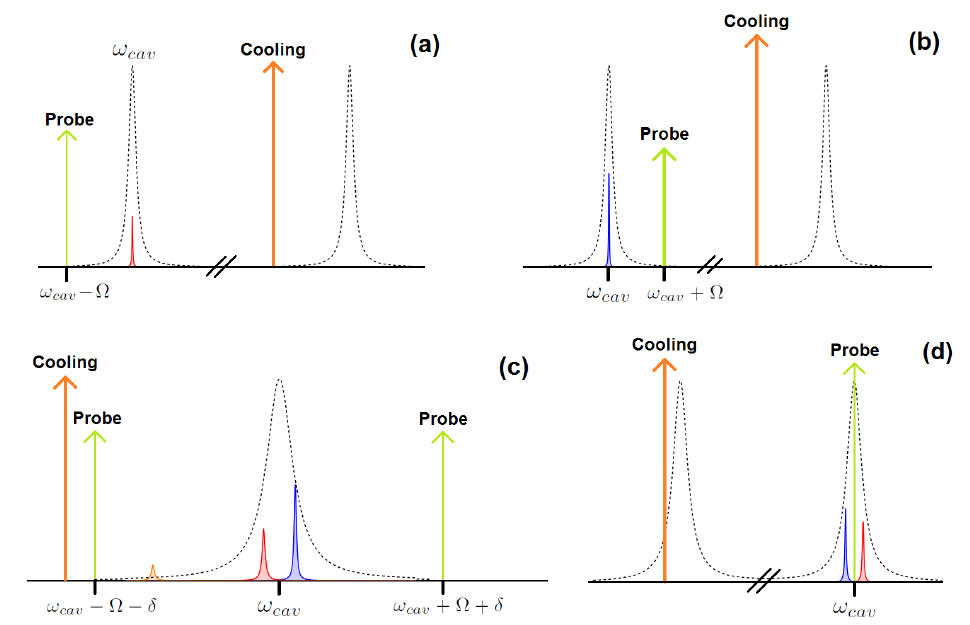
Figure 1: Different schemes to measure sideband asymmetry. The sidebands can be measured individually by placing the probe red(blue)-detuned (panel a (b)). Alter- natively, a single cavity mode can be probed with two tones, which create sidebands within the cavity linewidth (panel c). The sidebands can also be measured directly with a probe tone on resonance (panel d). Cooling tones are represented for com-